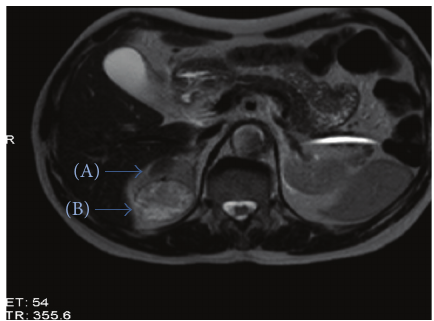
Figure 1: Preoperative MRI image of the patient. Cystic lesion (A) and solid lesion (B).